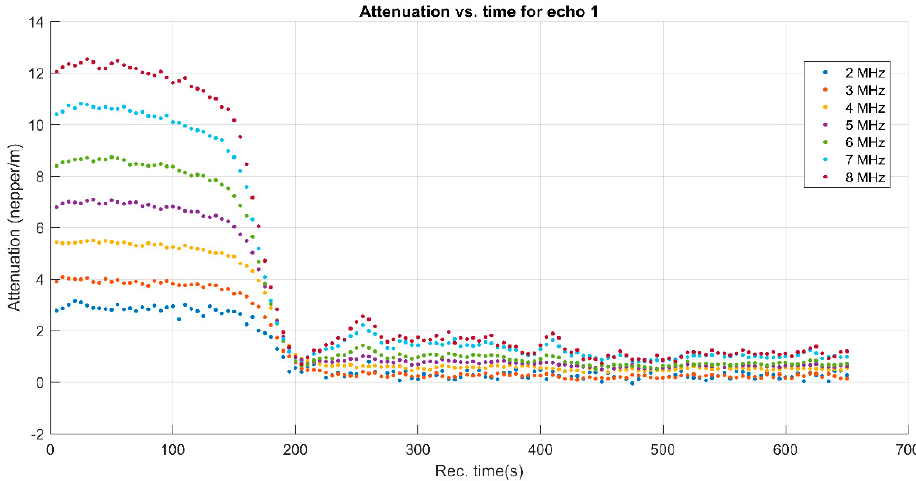
Figure 7. Attenuation vs. time for the spectral components of Echo 1.